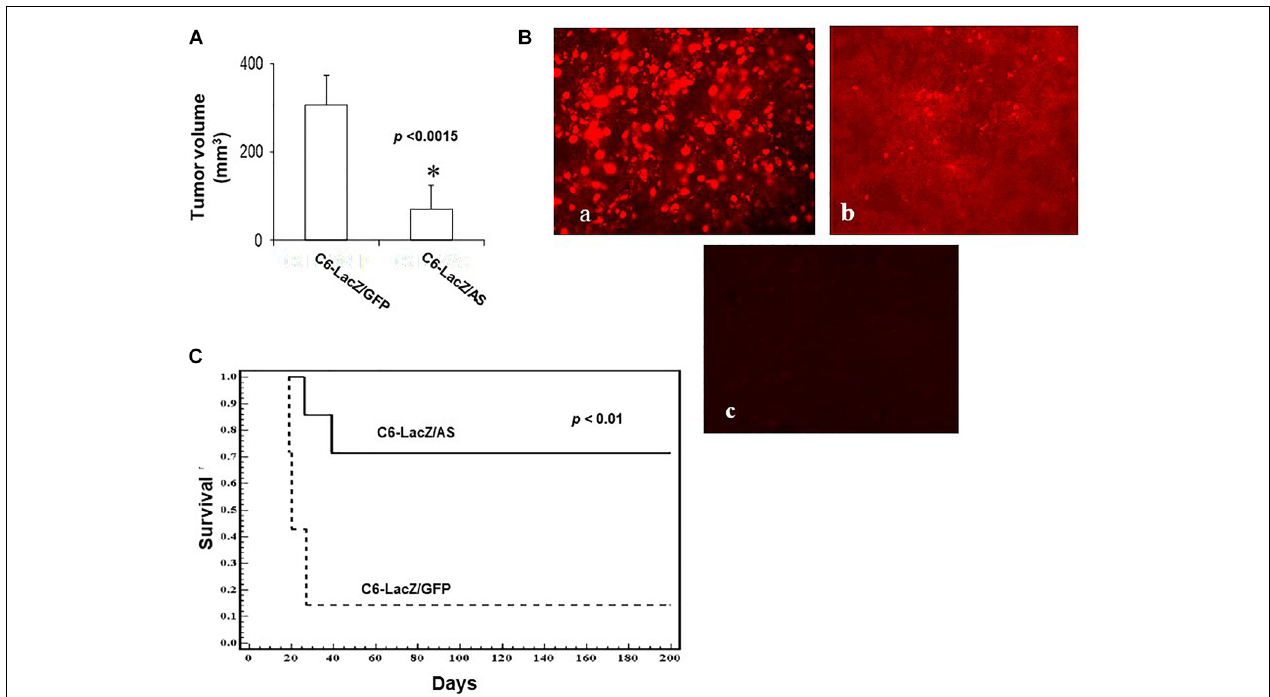
FIGURE 3 | Reduced intracerebral growth of C6/LacZ AS cells. Rats were implanted with 10 4 cells intra-cranially and the brains removed for tumor volume measurement as described in section “Materials and Methods.” Shown in (A) are the results of a representative experiment of two performed ( n = 5 in each, ∗ p < 0.0015). Shown in (B) are results of a TUNEL assay performed on representative sections. Apoptotic cells were visualized using Cy3-conjugated streptavidin ( a -C6/LacZ AS ; b -C6/LacZ GFP ). Control sections (c) prepared from C6/LacZ AS injected animals were treated in the same manner but without the terminal deoxynucleotidyl transferase (TdT) enzyme. Long-term survival of rats implanted intra-cranially with 10 4 C6/LacZ glioma cells (C) was analyzed in three independent experiments using 9–14 animals per group. The animals were followed until the onset of morbidity, at which point they were euthanized. Disease-free rats were euthanized 182 days post tumor implantation ( ∗ p <